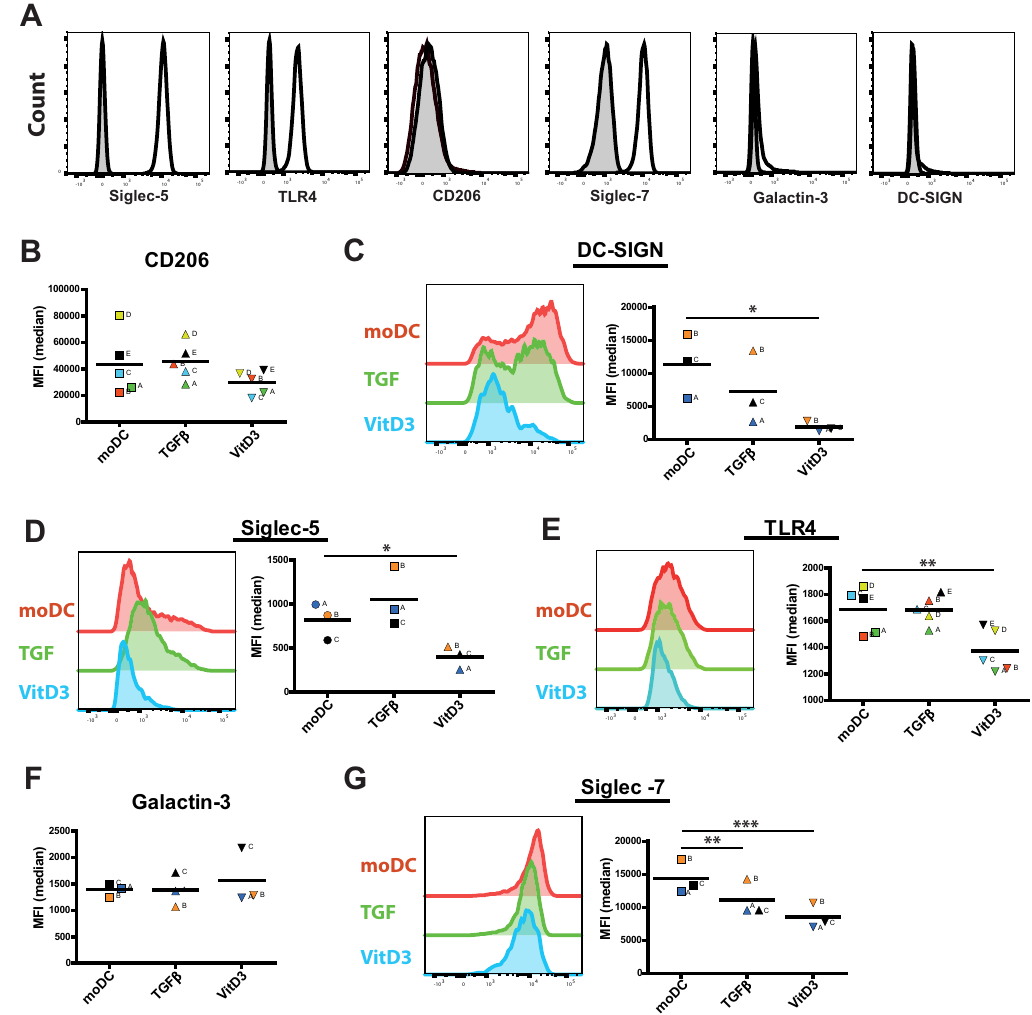
Fig 4. moDC, TGF β DC and VitD3DC express different levels of HMO-recognizing receptors. The expression of several receptors that are shown in literature to recognize HMOs were measured on A) monocytes and B-G) moDC, TGF β DC and vitD3DC. The expression of Siglec-5, Siglec-7, TLR4, CD206, Galactin-3 and DC-SIGN (open histograms) and their matching isotype control (shaded histograms) were measured on monocytes. The expression of B) CD206, C) DC-SIGN, D) Siglec-5, E) TLR4, F) Galactin-3 and G) Siglec-7 was shown by scatter plots (n = 3–5) and histogram of one representative donor. Normal distribution was assumed due to the low sample size. Significance was tested by a repeated measures ANOVA with a Tukey’s multiple comparison post-hoc